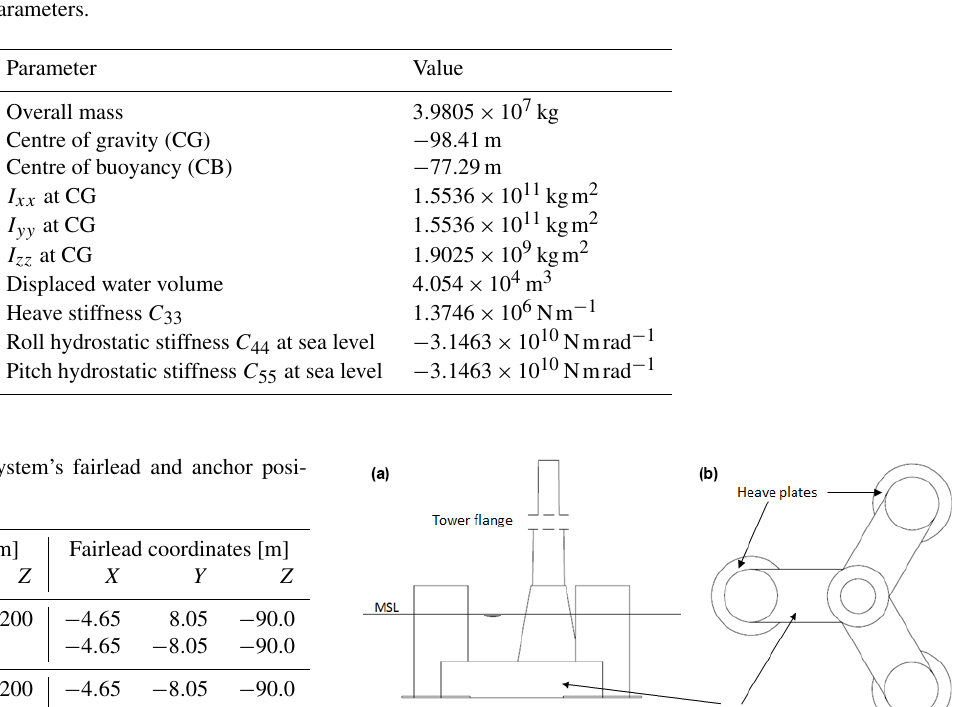
Table 3. WindCrete plus RNA parameters.